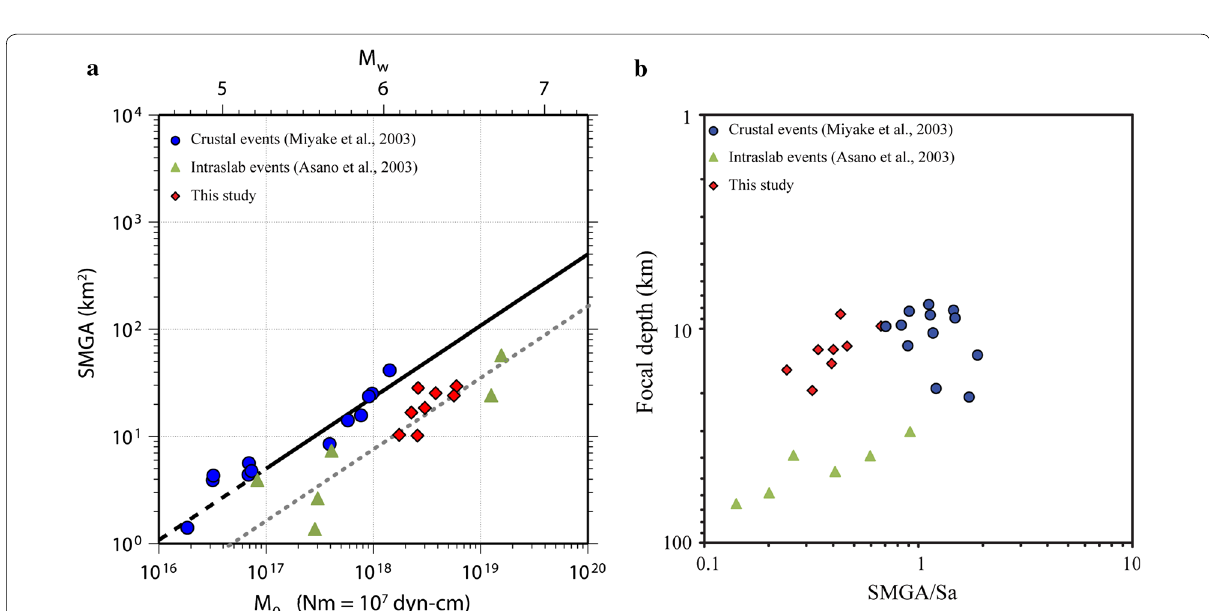
Fig. 5 Scaling relationship for a seismic moment versus SMGA and for b focal depth versus SMGA/ S a . The diamonds indicate events studied in this paper. Triangles and circles show events from previous studies. The solid line represents the empirical relationship proposed by Somerville et al. (1999), with the dashed lines as the extension for the smaller events. The dotted line shows the relationship, while the stress drop on the combined asperities is five times the value estimated from the empirical relationship of Somerville et al. (1999)